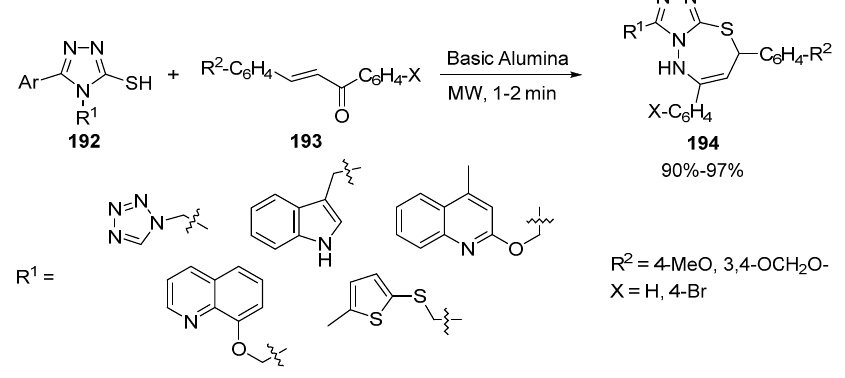
Scheme 38. Solvent free synthesis of thiadiazepines.